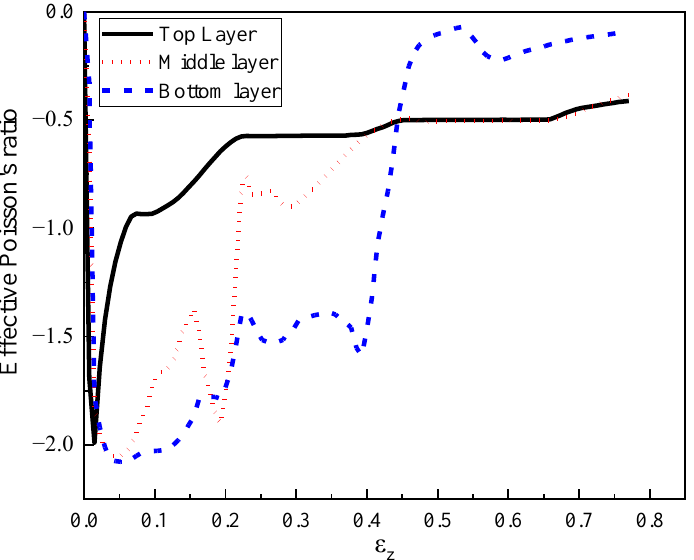
Figure 30. The effective Poisson’s ratio of each layer at a loading rate of 2 m/s ( t = 0.4:0.4:0.4 and ρ = 408:575:848).